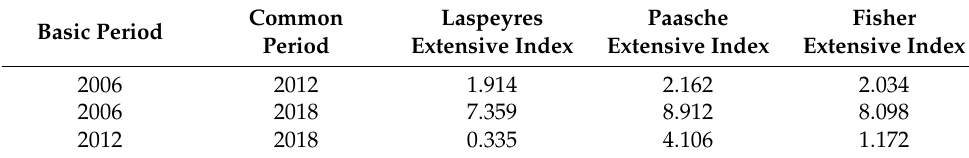
Table 2. Indexes of communal waste